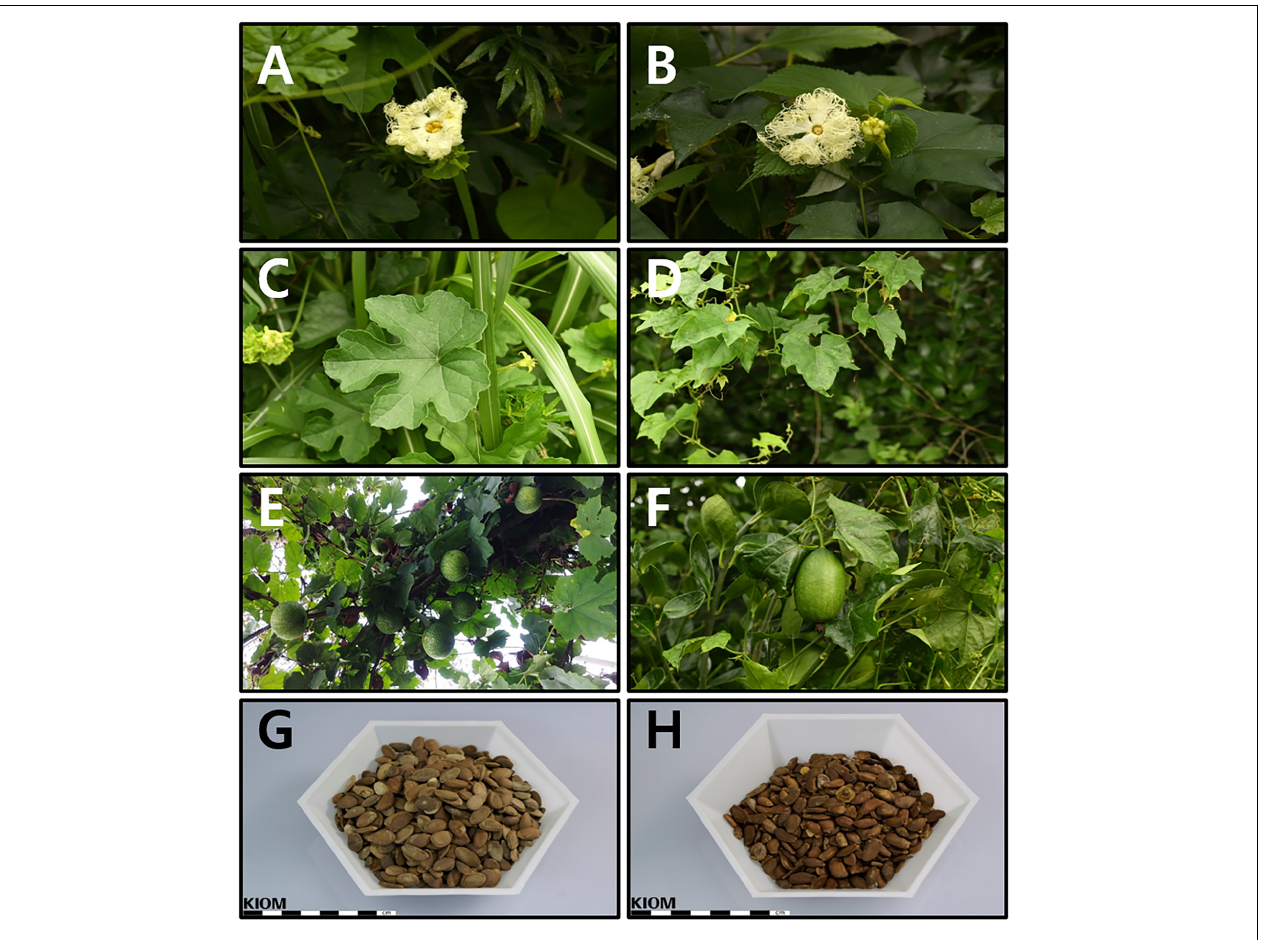
FIGURE 1 | Characteristics of Trichosanthes ( kirilowii var.) kirilowii and T. ( kirilowii var.) japonica in Korea (A) Inflorescence of T. kirilowii. (B) Inflorescence of T. japonica. (C) Leaf shape of T. kirilowii. (D) Leaf shape of T. japonica. (E) Fruit of T. kirilowii. (F) Fruit of T. japonica. (G) Seeds of T. kirilowii. (H) Seeds of T. japonica.